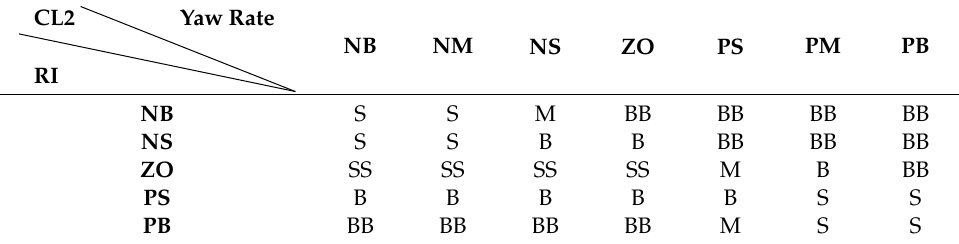
Table 4. Fuzzy rule: RI, yaw angle rate and damping reference coe ffi cient of rear right wheel.